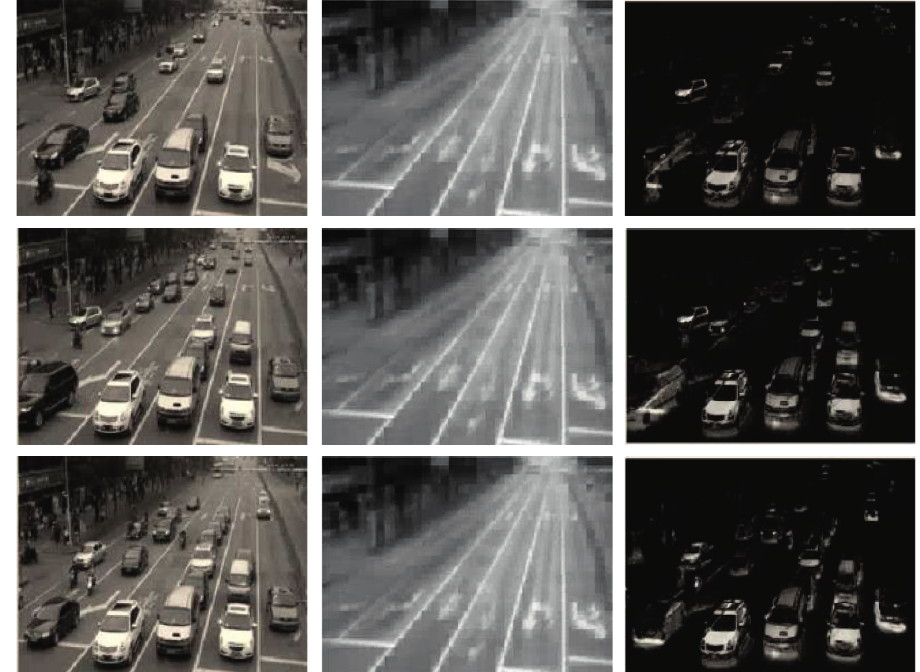
Figure 5: Detection results of our method.